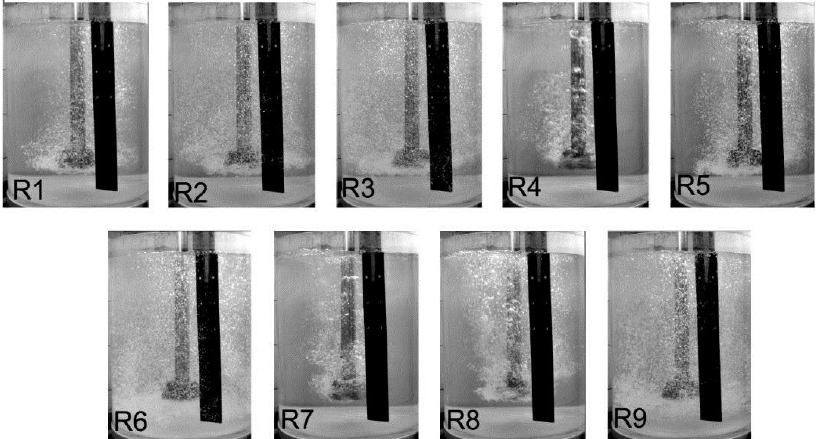
Figure 5. The level of dispersion registered for different processing parameters, according to Table 2, for the commercial design rotary impeller C.